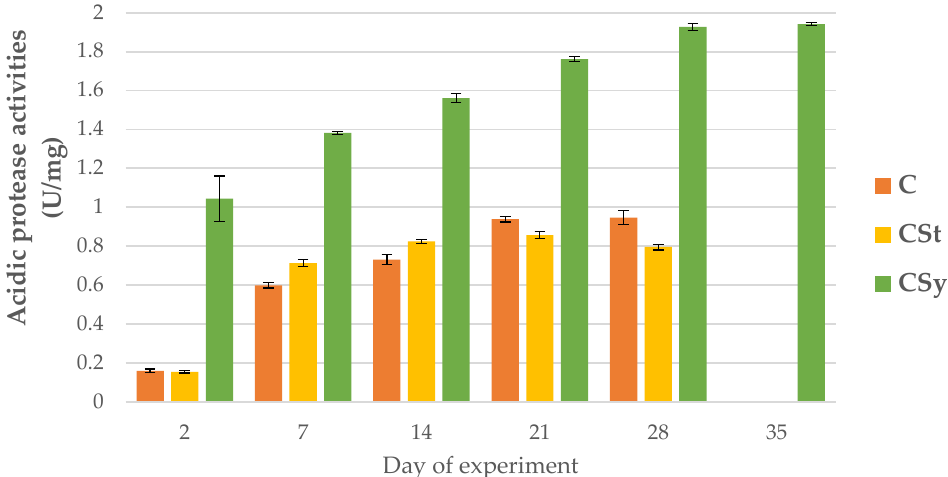
Figure 2. Acidic protease activities in the 2, 7, 14, 21, 28, 35-day-old honey bees’ hemolymph after two methods of supplementation with hemp extract: C-control (pure sugar syrup), CSy-hemp extract in syrup, CSt-hemp extract on strips. Two-Way ANOVA: supplementation method: F (2, 156) = 182,90, p = 0.0000, se ± 0.042535–0.038439; days of supplementation: F (4, 143) = 2518.9, p = 0.0000, se ± 0.006184–0.01071; supplementation method × days of supplementation: F (8, 143) = 71.420, p = 0.0000, se ± 0.01071–0.01129.